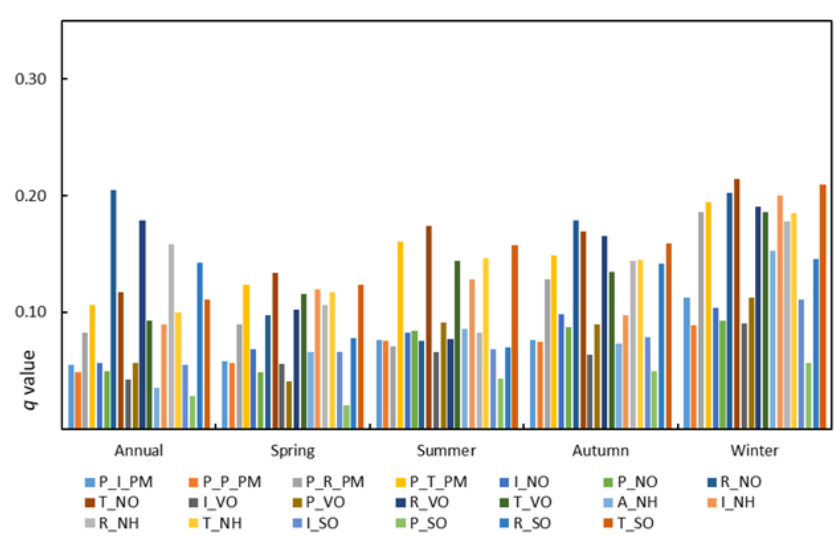
Figure 2. The q value of the driving factor on the national annual and seasonal scales. (P_I_PM denotes primary industry PM 2.5 ; P_P_PM denotes primary power PM 2.5 ; P_R_PM denotes primary residential PM 2.5 ; P_T_PM denotes primary transportation PM 2.5 ; I_NO denotes industrial NO X ; P_NO denotes power NO X ; R_NO denotes residential NO X ; T_NO denotes transportation NO X ; I_VO denotes industry VOC S ; P_VO denotes power VOC S ; R_VO denotes residential VOC S ; T_VO denotes transportation VOC S ; A_NH denotes agricultural NH 3 ; I_NH denotes industrial NH 3 ; R_NH denotes residential NH 3 ; T_NH denotes transportation NH 3 ; I_SO denotes industrial SO 2 ; and P_SO denotes power SO 2